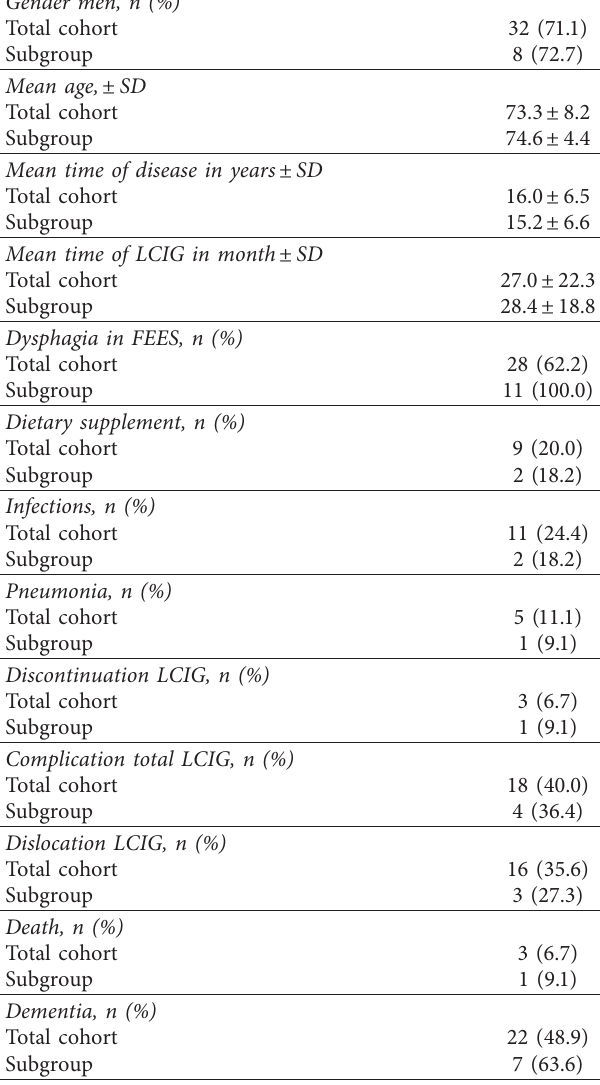
Table 1: Descriptive statistics for the total cohort as well as for the subgroup with follow-up FEES examinations before and after beginning with levodopa-carbidopa intestinal gel (LCIG).